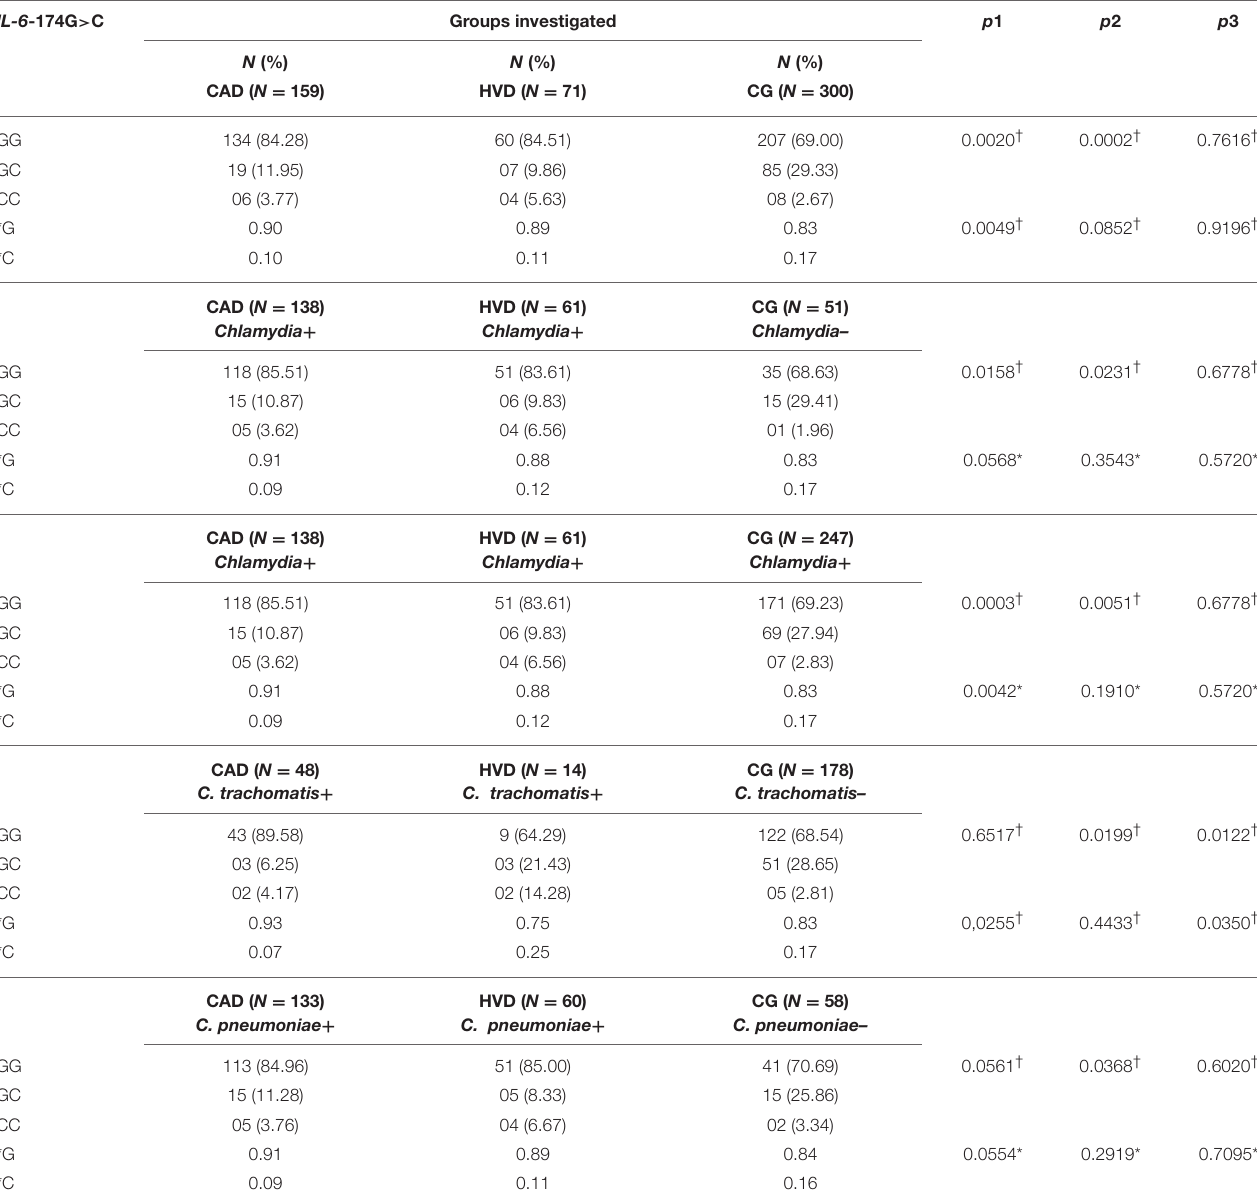
TABLE 4 | Genotypic and allelic distributions of IL-6 -174G > C markers among cardiac patients according to the presence of antibodies to Chlamydia and to the C. trachomatis and C. pneumoniae species. IL-6 -174G >